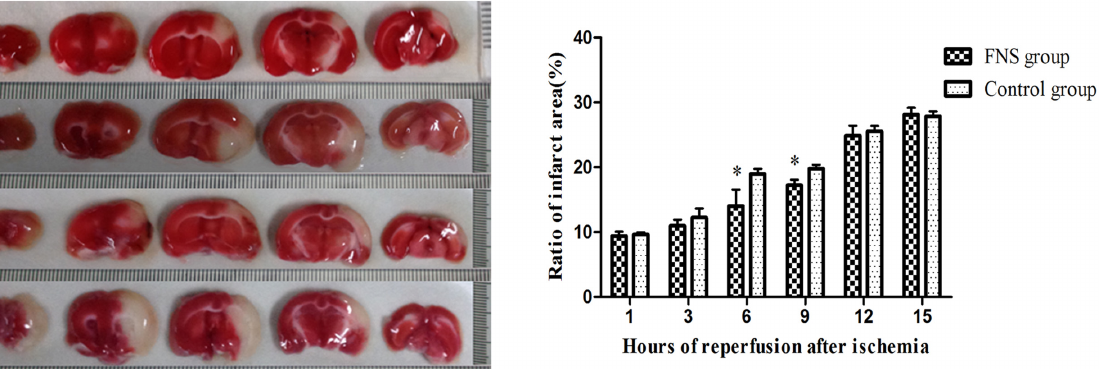
Fig 6. The measurement of infarct volume by TTC staining. (A): the 6h FNS group; (B): the 6h control group; (C): the 9h FNS group; (D): the 9h control group. The infarct area was shown as white color, and FNS significantly reduced the infarct volume. Results are expressed as the mean ± SD. * p < 0.05, vs the control group, n = 5.